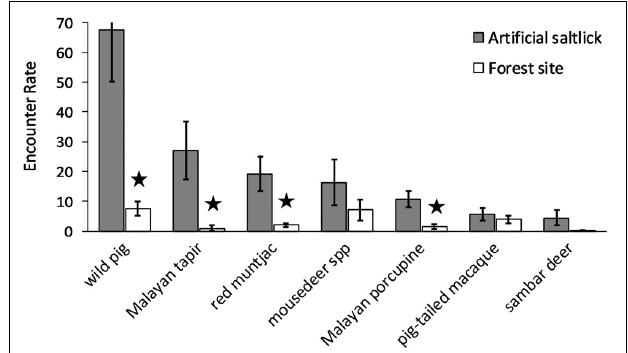
FIGURE 2 | Mean encounter rates for frequent species visiting artificial saltlicks and forest sites. Frequent species were considered those with artificial lick-site encounter rates of ≥ 3 visits 100TN − 1 . Error bars are standard errors. Encounter rates are independent pictures 100TN − 1 . Star denotes significantly different encounter rates ( p ≤ 0.05) assessed with paired T